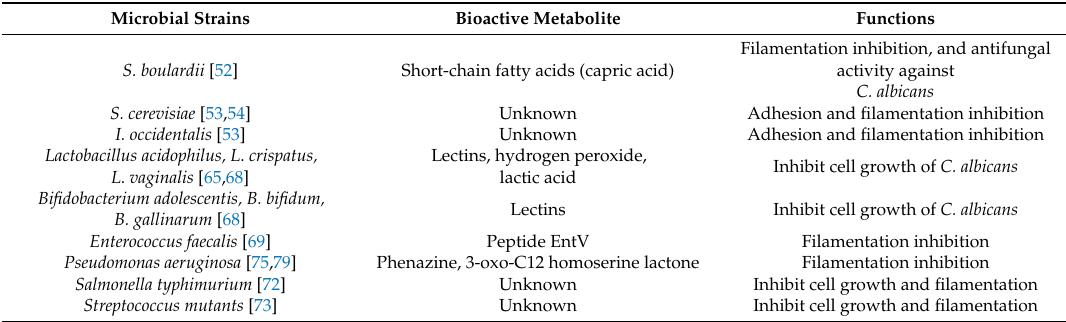
Table 2. Microbial metabolites and its functions against Candida